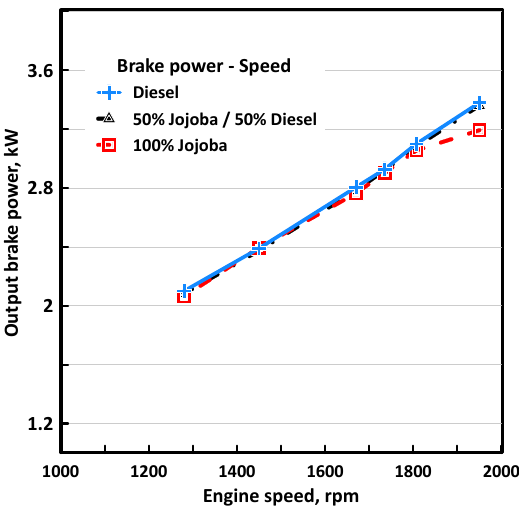
Figure 4. Brake power output versus engine speed for diesel fuel and raw Jojoba oil.